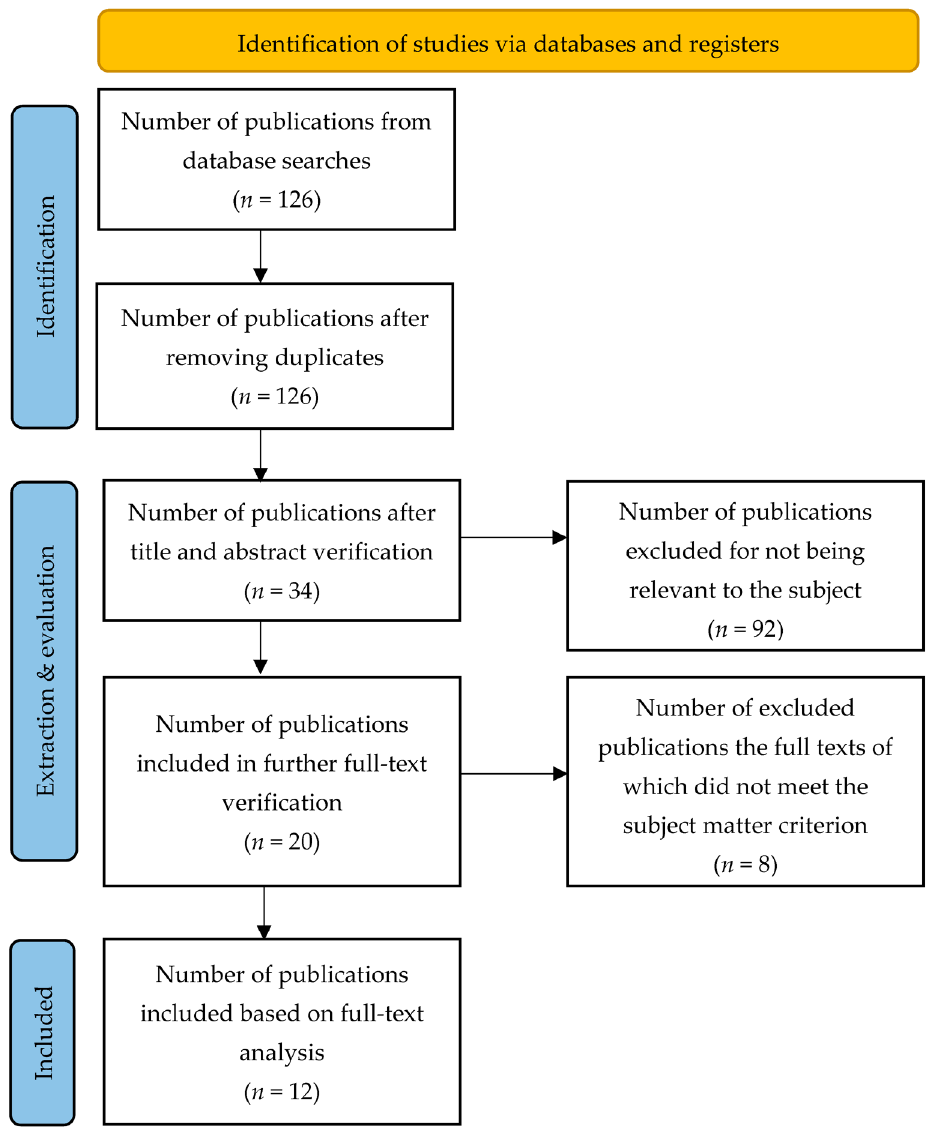
Figure 1. Simplified PRISMA scheme for inclusion of publications for further review.